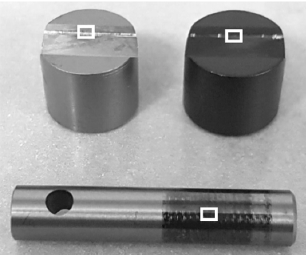
Figure A2. Tested vee blocks and pin: on the left—uncoated vee block; on the right—(W ‐ DLC/CrN) ‐ coated vee block.